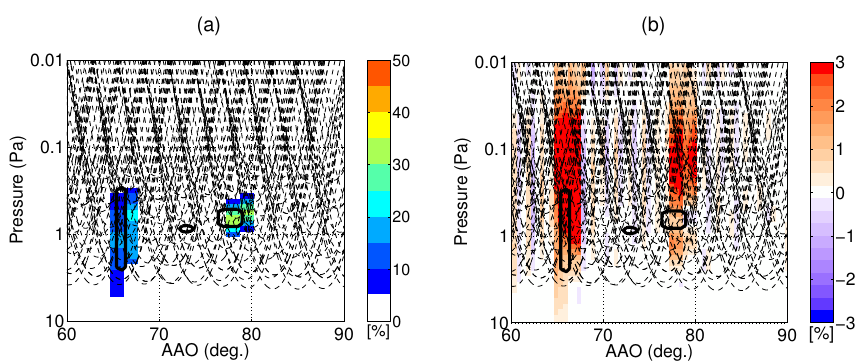
Figure 5. Water vapour (a) and temperature (b) from 1-D retrievals where a 50% enhancement of water vapour is simulated in the areas marked by the black squares. The results are presented in terms of deviation from the a priori (% and K). The dashed lines show the lines-of-sight of SMR.